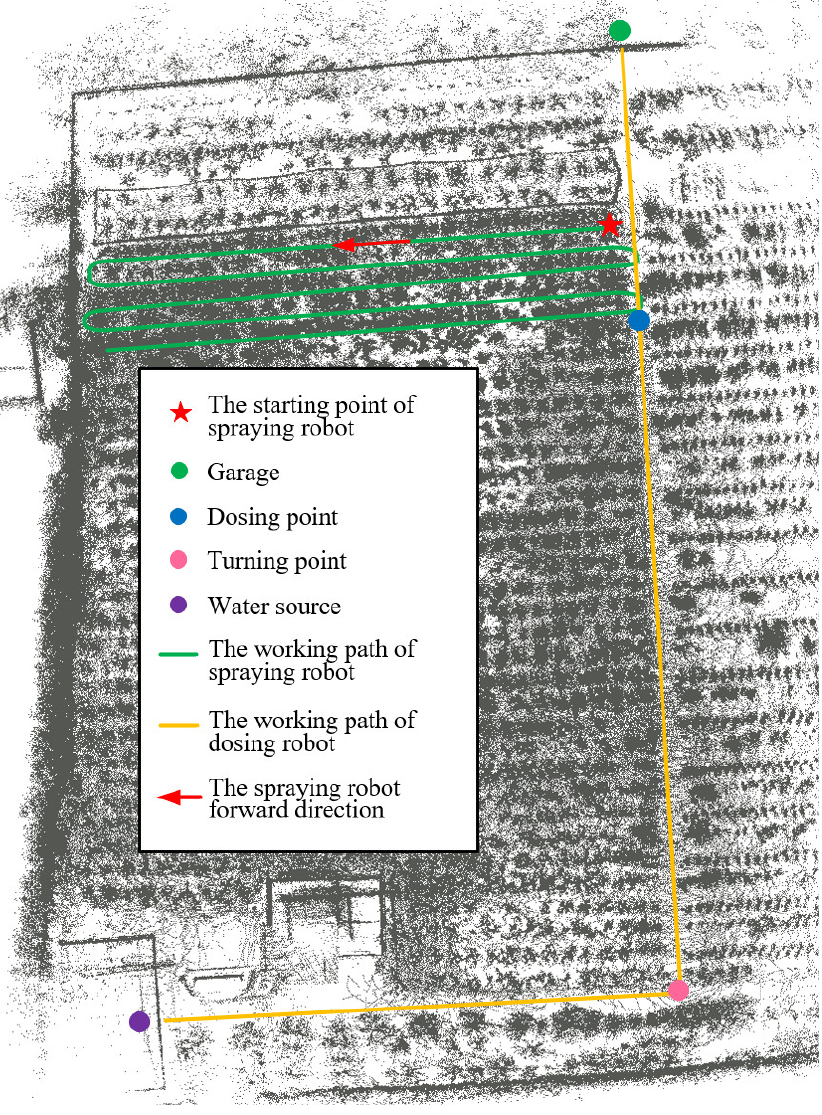
Figure 17. Pre-set path for spraying–dosing robot group. In Figure 18, a preset point is set at the midpoint of each end of the row, and the two points are connected as a preset path for spraying between the rows. The spraying robot adopts smooth steering when turning at the head of the ground, so two path points are needed at the head of the ground to assist in turning